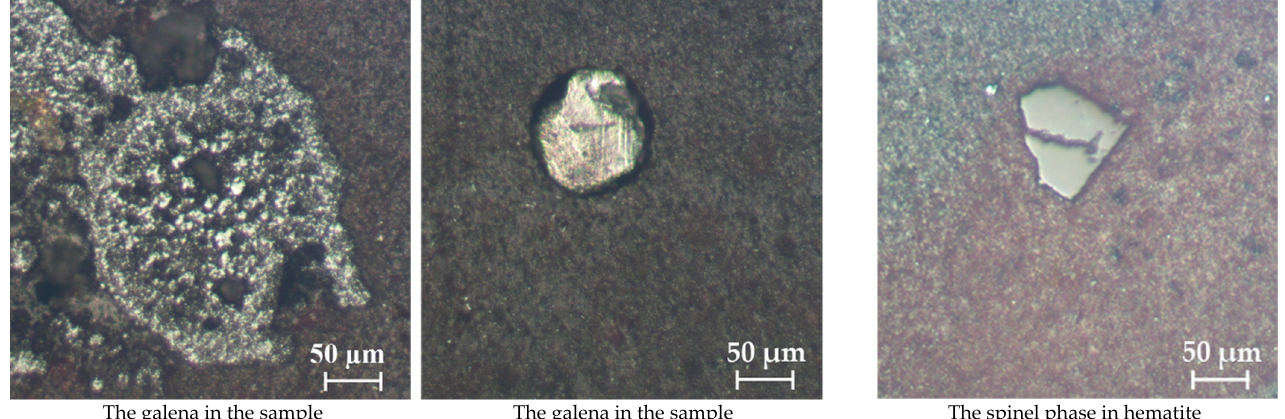
Figure 19. Optical microscopy of sulfidized jarosite-PbAg sludge with the addition of sulfur and carbon for magnetic separation.